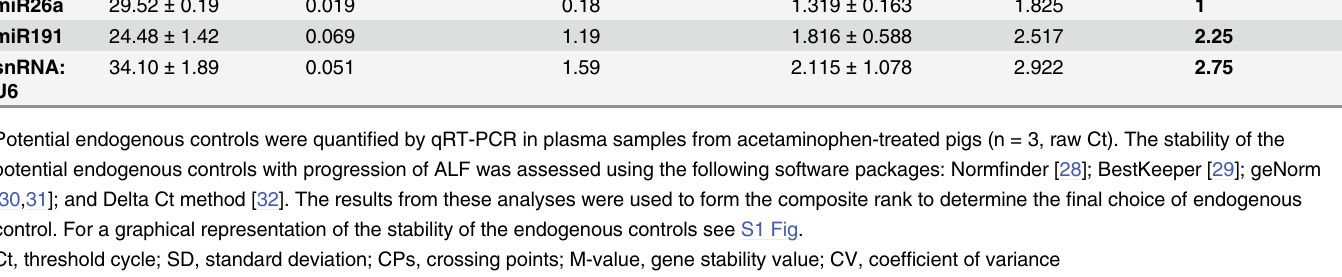
Table 1. Assessment of potential endogenous controls, snRNA:U6, miR26a and miR191, for use in porcine studies of ALF, using miR122 as the target miRNA. Gene Raw Ct Norm fi nder (Stability (Mean ± SD) value)